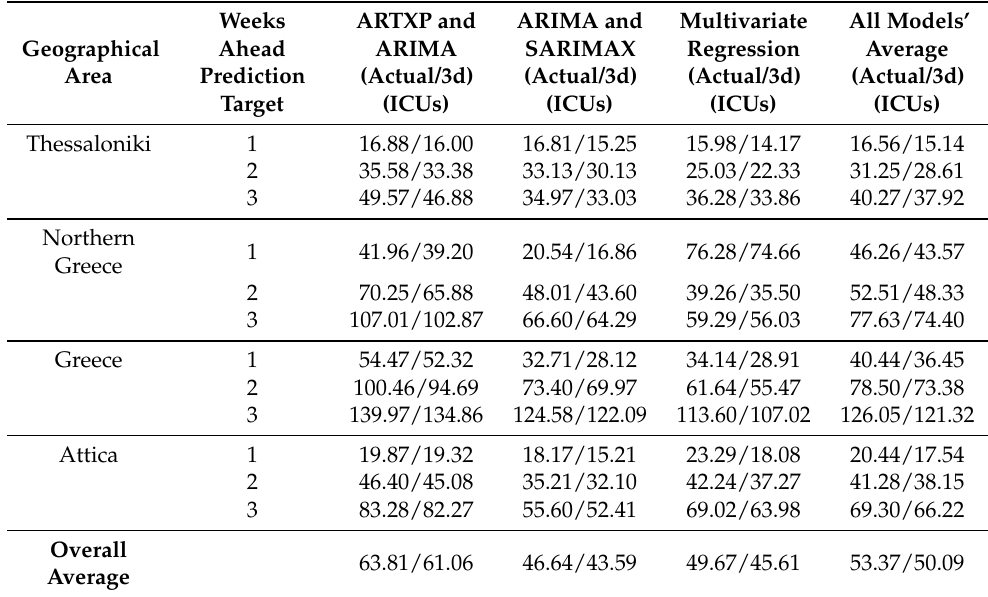
Table 3. RMSE of Predicted vs. Actual